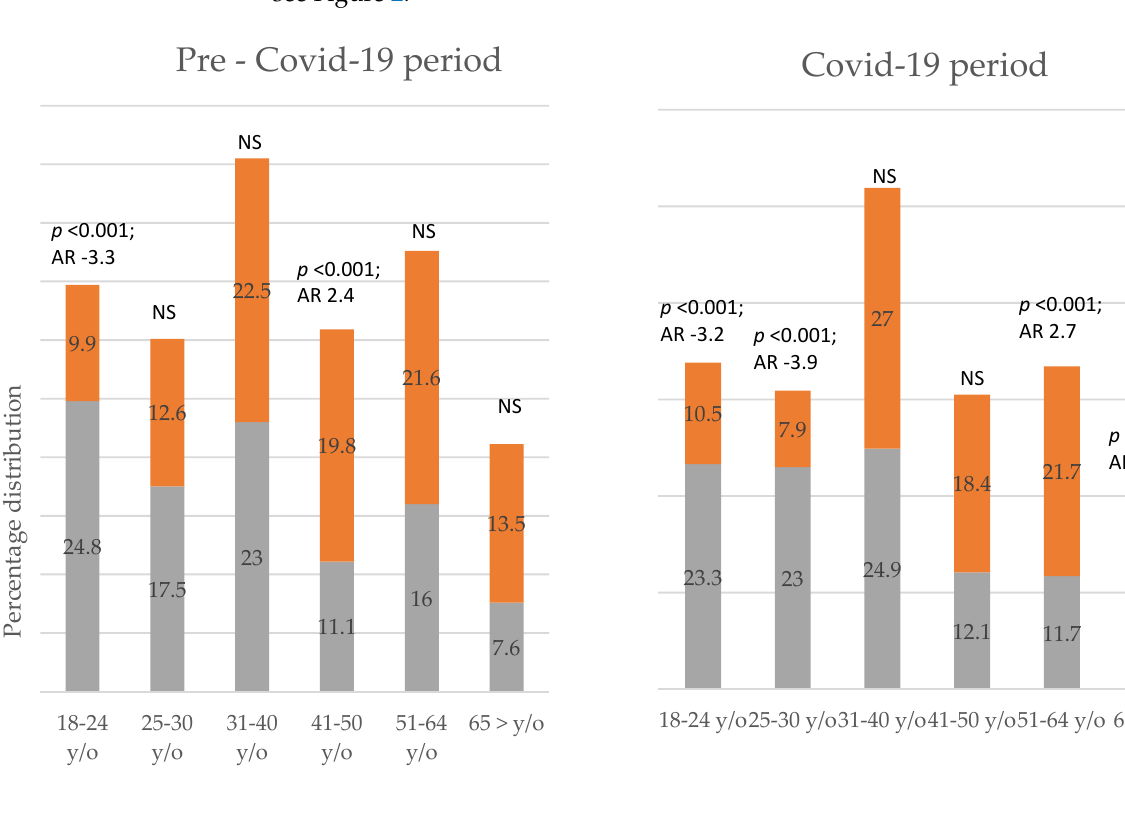
Figure 2. Frequency of uncomplicated and complicated appendicitis in every age group.